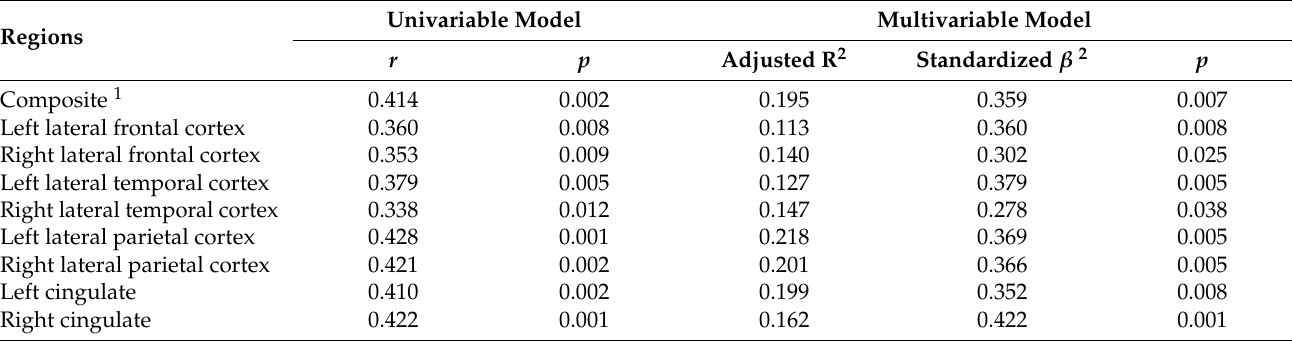
Figure 3. Association of visceral adipose tissue (VAT) metabolism with cerebral amyloid burden. Pearson’s correlation analysis revealed that VAT maximum standardized uptake volume (SUV max ) correlated positively with composite regional standardized 18 F-FBB uptake value ratios (SUVR FBB ) ( A ), and all regional SUVR FBB values in the bilateral lateral frontal ( B , C ), lateral temporal ( D , E ), and lateral parietal ( F , G ) cortices, as well as the bilateral cingulate cortices ( H , I ). Table 4. Association between visceral adipose tissue SUV max and cerebral A β burden in the over- all